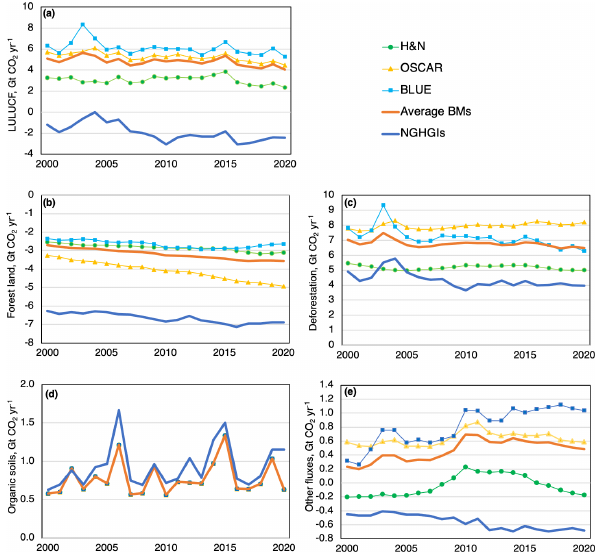
Figure 3. CO 2 fluxes from LULUCF between 2000 and 2020 (panel a ), forest land ( b , including harvested wood products and excluding organic soils), deforestation (c) , organic soils (d) , and other fluxes ( e , including cropland and grassland), from bookkeep- ing models (BMs) and national GHG inventories (NGHGIs). The values of BMs are those used in the Global Carbon Budget 2022 (Friedlingstein et al., 2022); values for NGHGIs are from Grassi et al. (2022), updated for the DRC in this study. For organic soils, the same external dataset is used by all BMs, and their lines thus lie on top of each other.